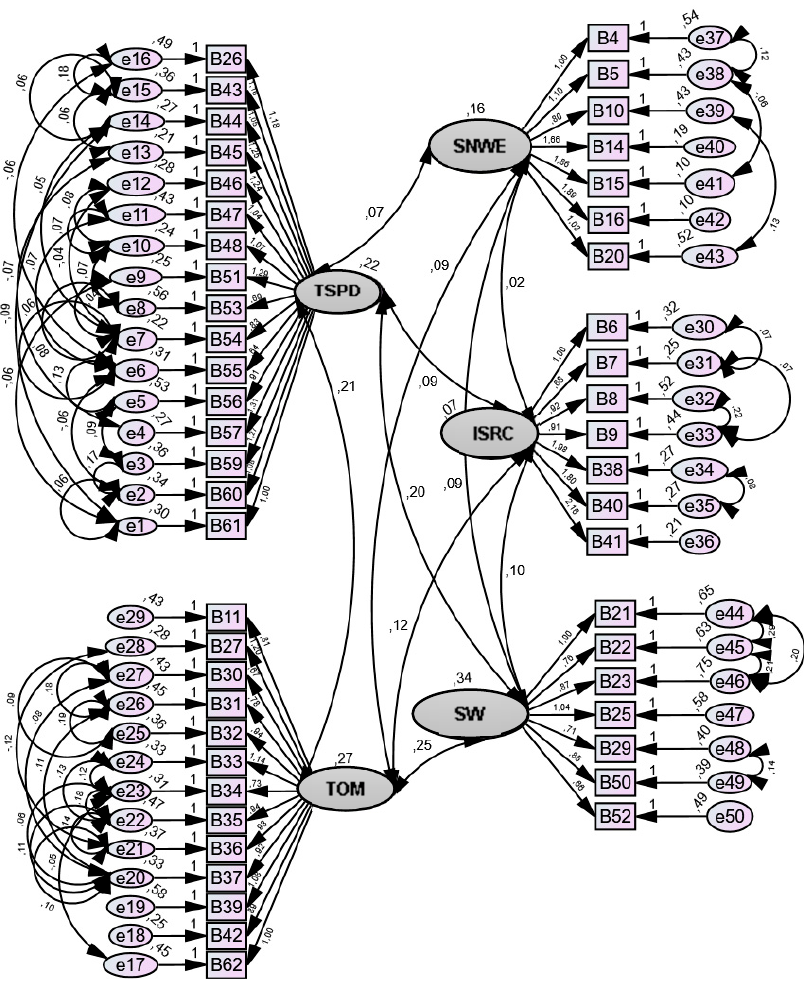
Figure 1. Five-factor model of the IQN-WE-PT scale.